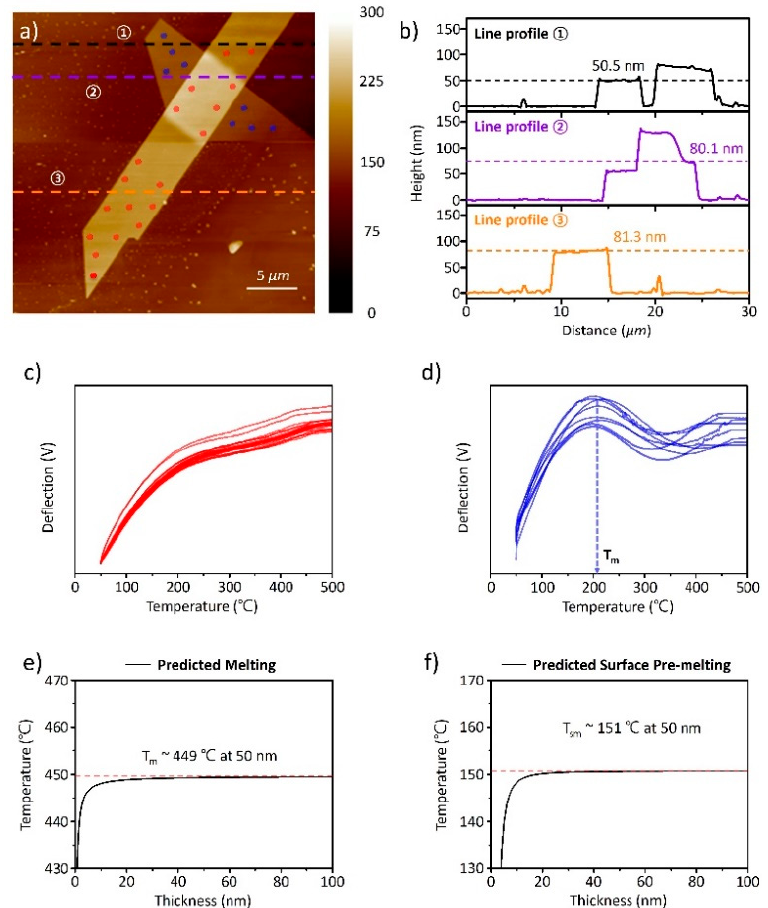
Figure 3. AFM combined Nano TA of 2D Tellurium. ( a ) AFM images and ( b ) three different line profiles are shown in ( a ); ( c , d ) Nano TA curves of 2D Tellurium according to different thicknesses presented in ( a ); Models for predicting ( e ) melting point and ( f ) surface pre-melting point for 2D Tellurium.